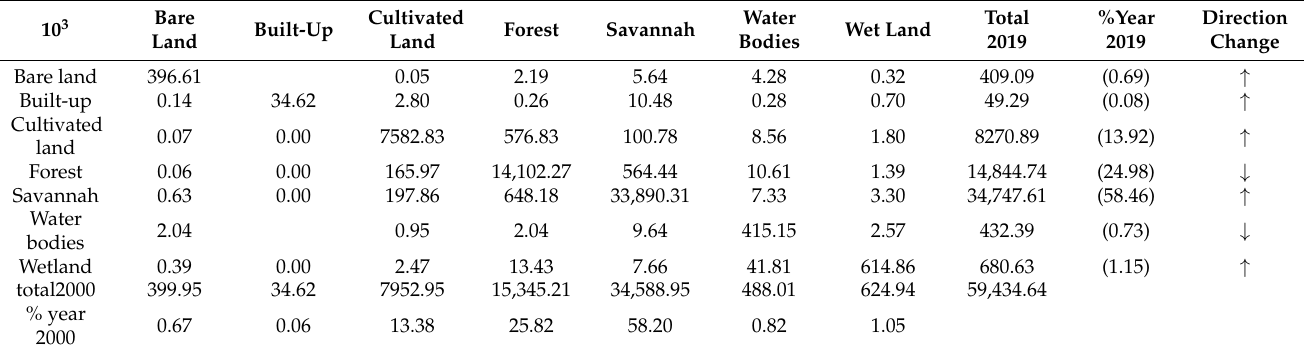
Table 3. Madagascar island LULC change (sq. ha) conversion matrix from 2000 to 2019.